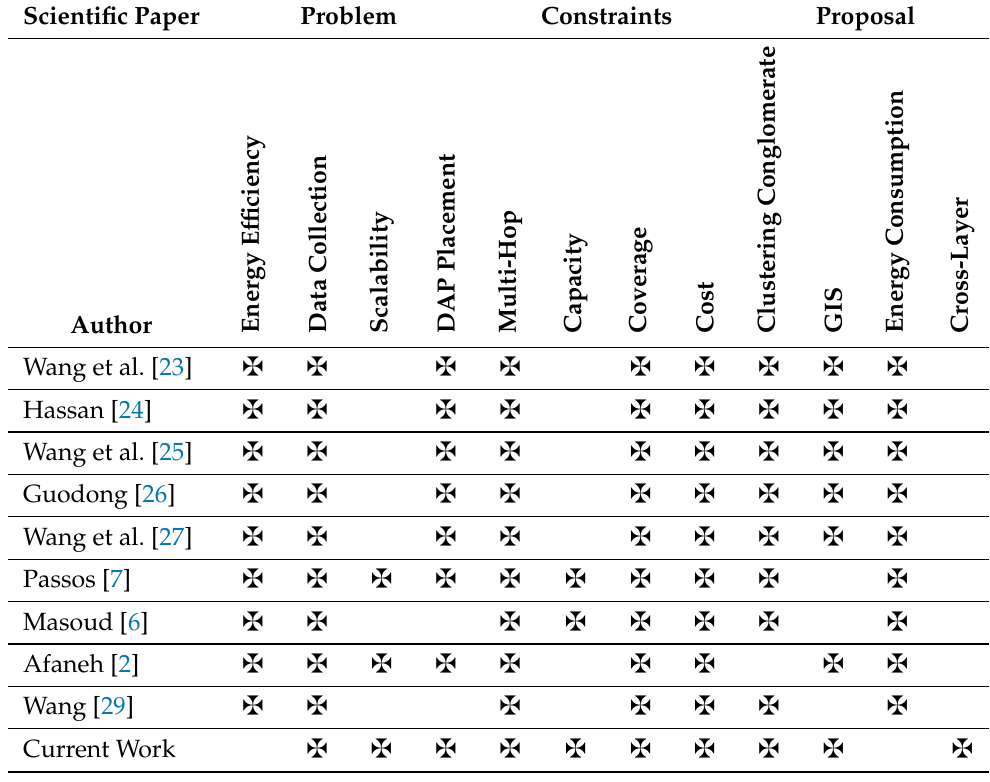
Table 1. Summary of papers related to the sizing and geo-referenced routing of wireless sensor networks. Scientific